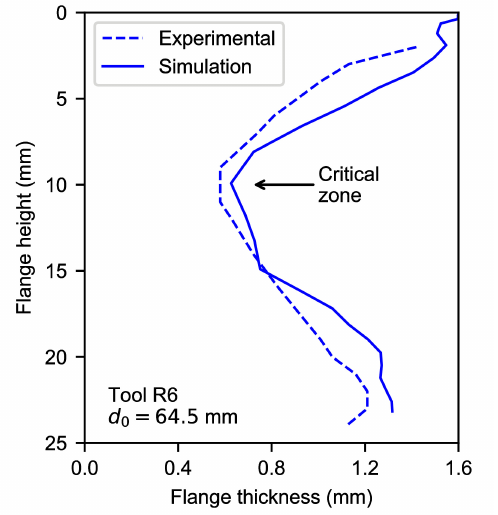
Figure 9. Thickness distribution along the flange of a hole-flanging process by single-stage SPIF: simulation and experiment